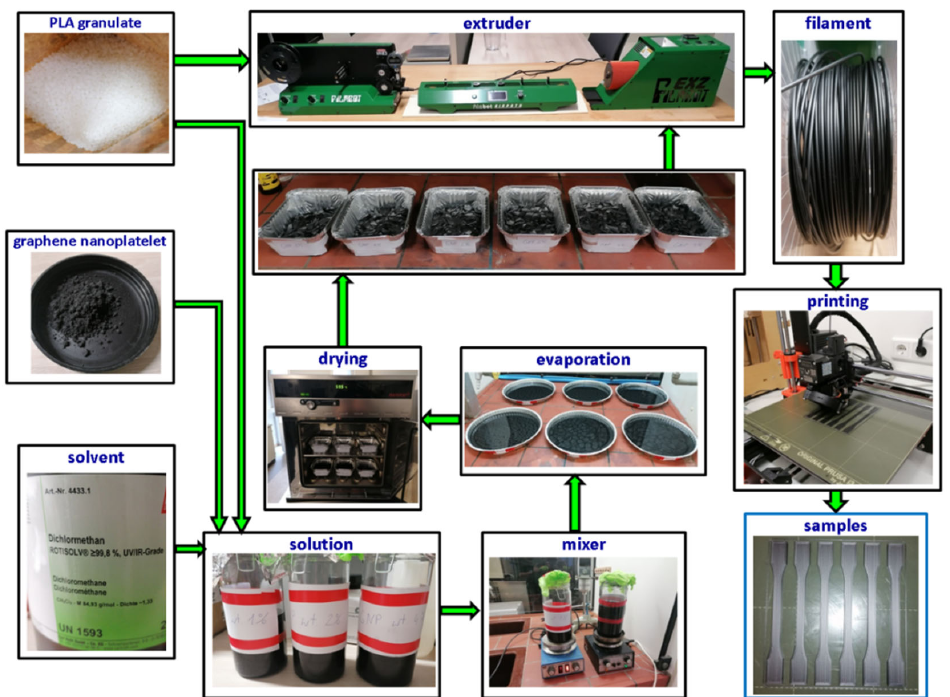
Figure 1. Schematic course of preparing printed samples made of pure PLA and PLA with GNP.